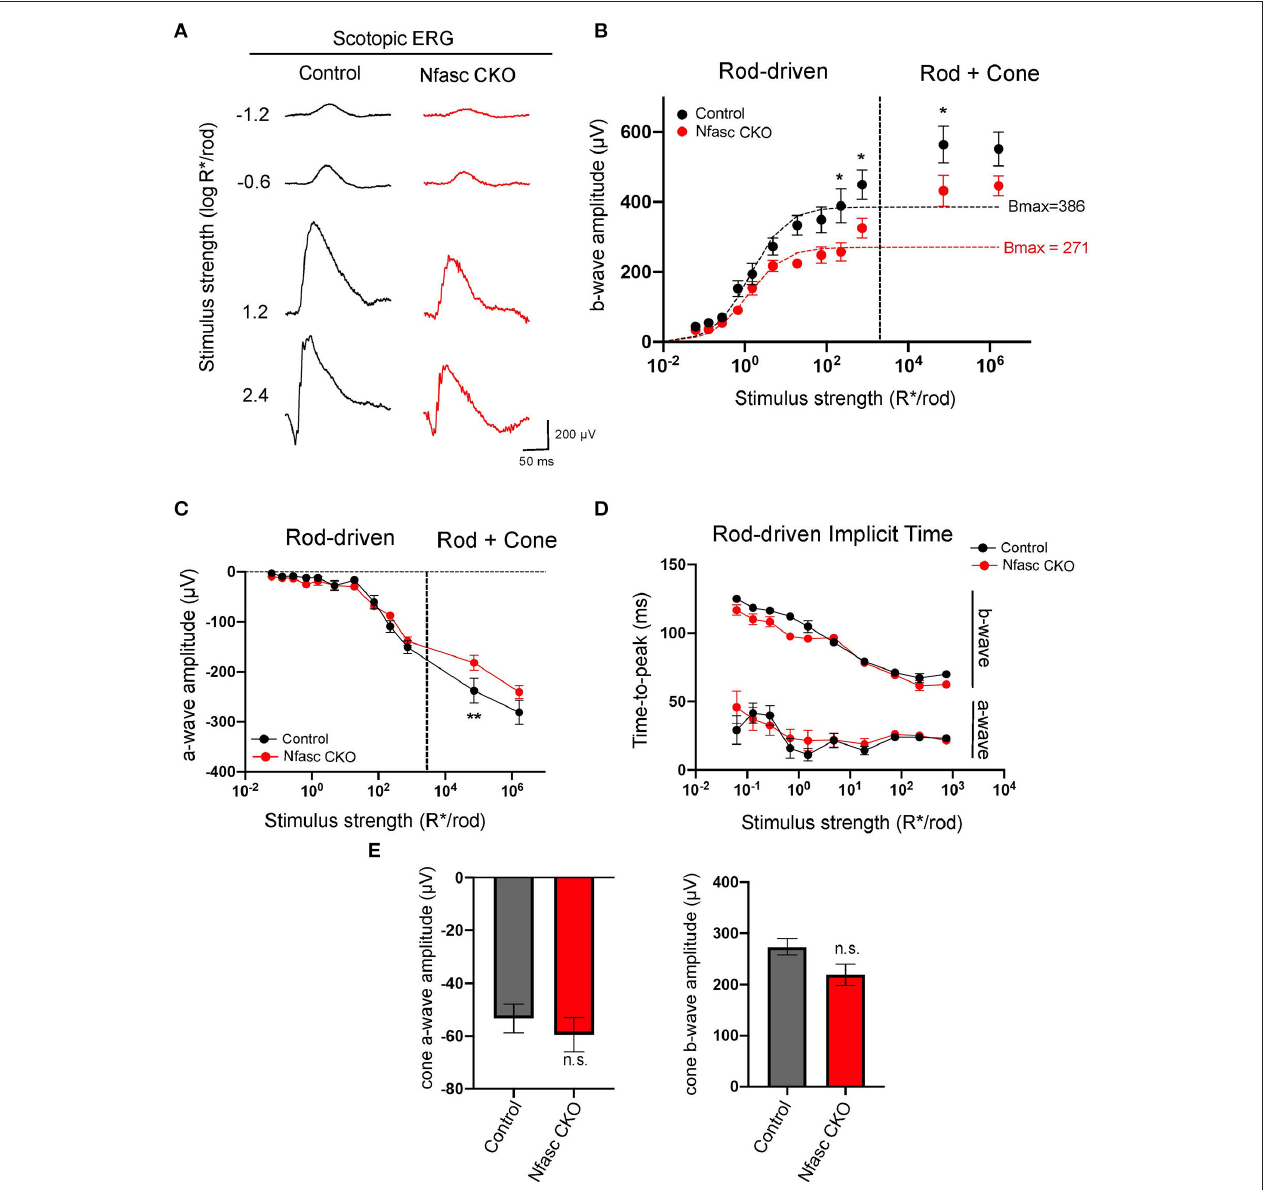
FIGURE 5 | Electroretinograms (ERG) from Nfasc CKO mice (A–E) . ERG traces of control (black) and Nfasc CKO (red) mice at different scotopic (rod-driven) stimulus intensities (A) . Stimulus response plot showing b-wave amplitudes of dark-adapted control (black, n = 8 from four mice) and Nfasc CKO (red, n = 8 from four mice). Data points within the rod operative range are fitted with a hyperbolic saturating curve using the Naka-Rushton equation. Dotted line denotes the approximate threshold for cone photoreceptors (B) . Stimulus response plot of scotopic a-wave amplitudes of control (black, n = 8 from four mice) and Nfasc CKO (red, n = 8 from four mice) (C) . Implicit times for scotopic ERG a-wave and b-wave responses as a function of stimulus intensity (D) . Isolated amplitudes of the cone a-wave and b-wave using the paired flash method (E) . Data represented as mean values ± SEM. Statistical significance determined by Holm-Sidak method for multiple comparisons. * p < 0.05, ** p <